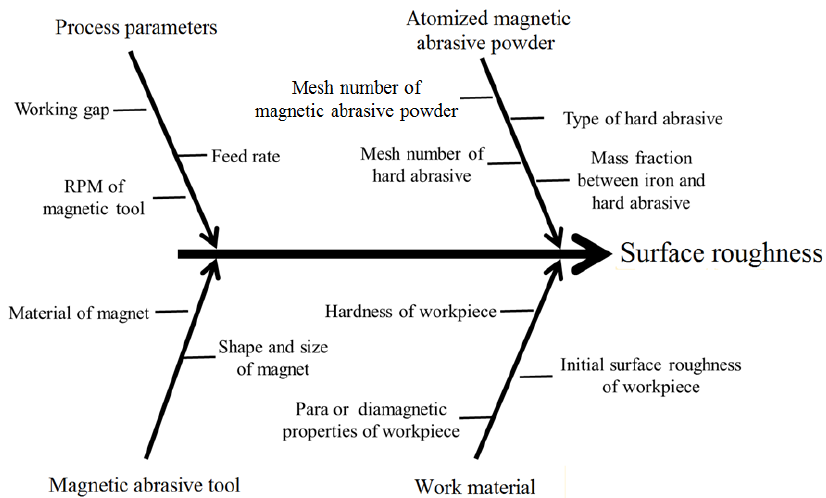
Figure 7. Fishbone diagram showing important process parameters.